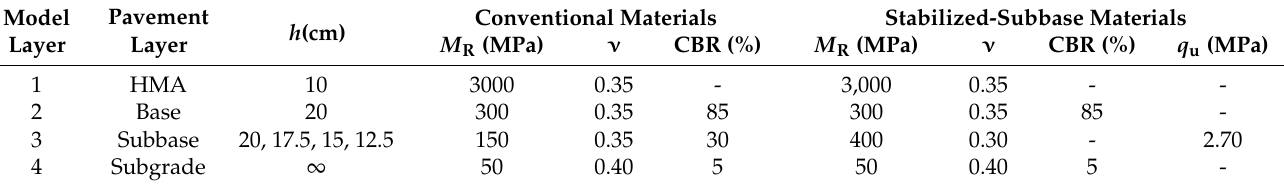
Table 6. Input model parameters.